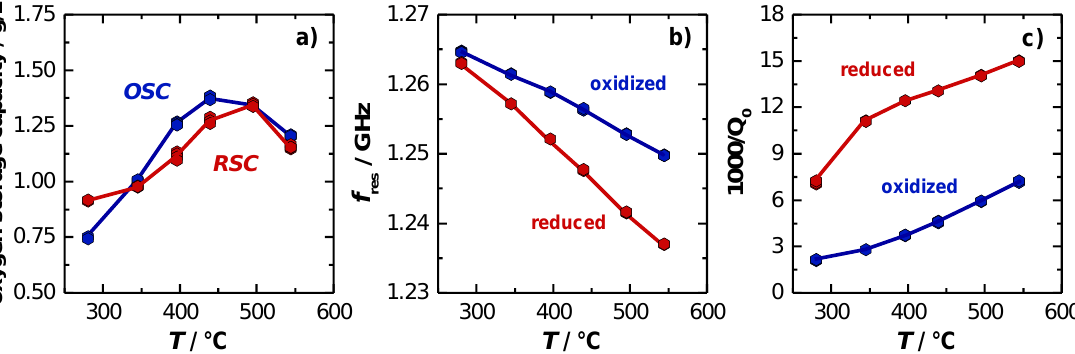
Figure 4. ( a ) Effect of catalyst temperature on oxygen storage and release capacity ( OSC , RSC ). Effect of catalyst temperature and oxygen storage level on ( b ) resonant frequency and ( c ) unloaded quality factor. The change in 1000/ Q 0 is referred to as amplitude of the (unloaded) quality factor in the following.